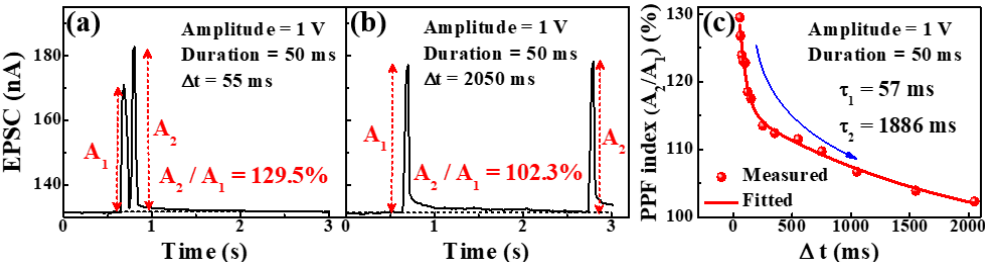
Figure 6. Paired-pulse facilitated excitatory post-synaptic current (EPSC) for ( a ) 55 ms and ( b ) 2050 ms intervals under the pulse amplitude of 1 V and duration of 50 ms. ( c ) PPF index with ∆t ranging from 55 ms to 2050 ms. For the EPSC measurement of multiple presynaptic stimulation spikes, a pre-synap- tic spike (4 V, 200 ms) was applied to the gate electrode, and a read voltage (V D = 1V) was